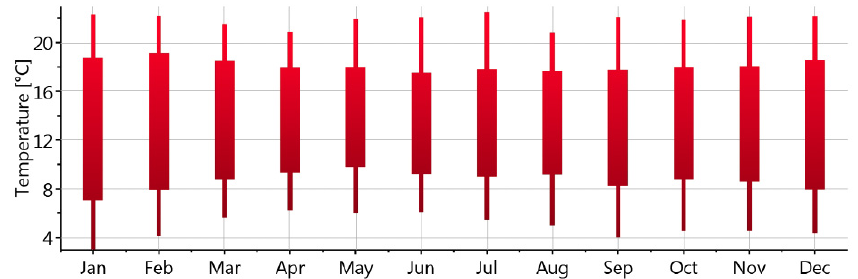
Figure 2. Monthly average temperatures for the city of Bogotá. Source: Meteonorm 7.0.